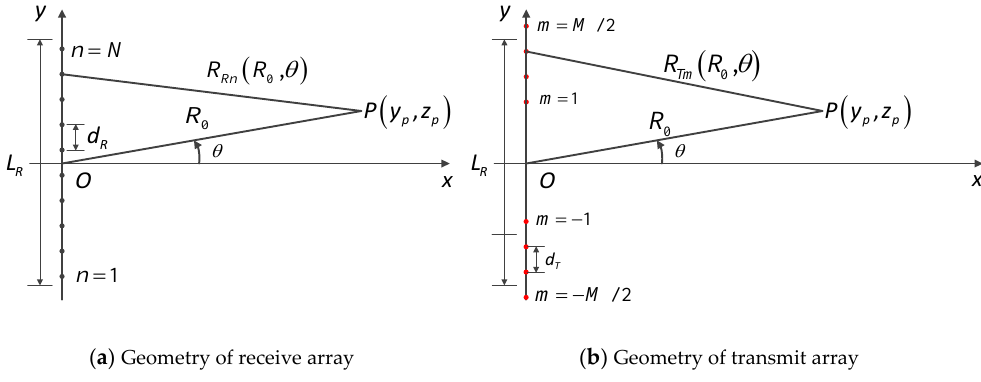
Figure 4. Geometry of MIMO arrays.